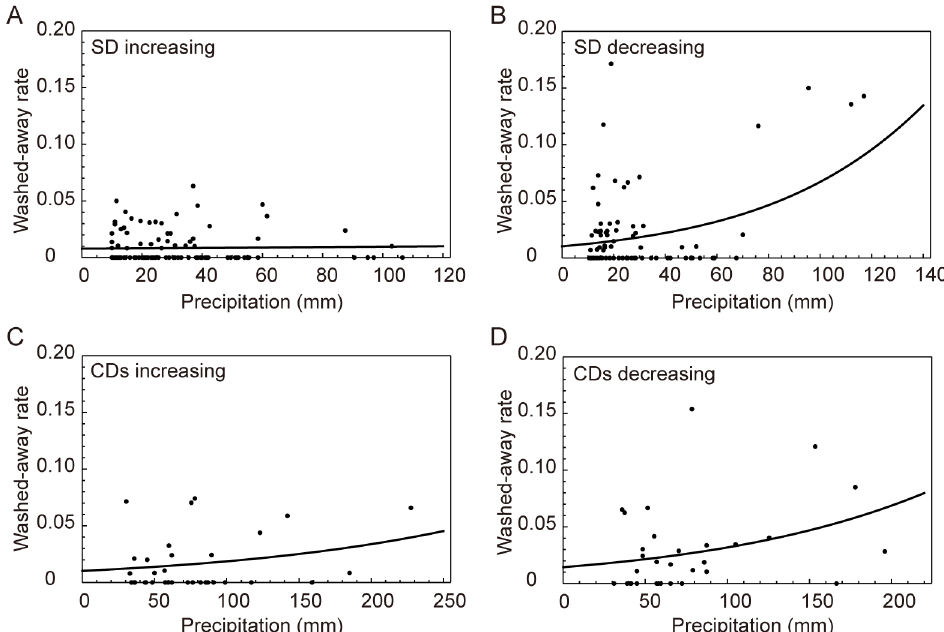
Fig 5. Relationships between the wash-out rates and precipitation during the increasing and decreasing periods. (A) Single-day rains (SD) in the increasing period (between Dates I and II). (B) SD in the decreasing period (after Date II). (C) The continuous-days rains (CDs) during the increasing period. (D) CDs during the decreasing period. SD denotes that the rain stopped in a single day, and CDs indicates that the rain continued over multiple days. Dates I – IV are defined in the